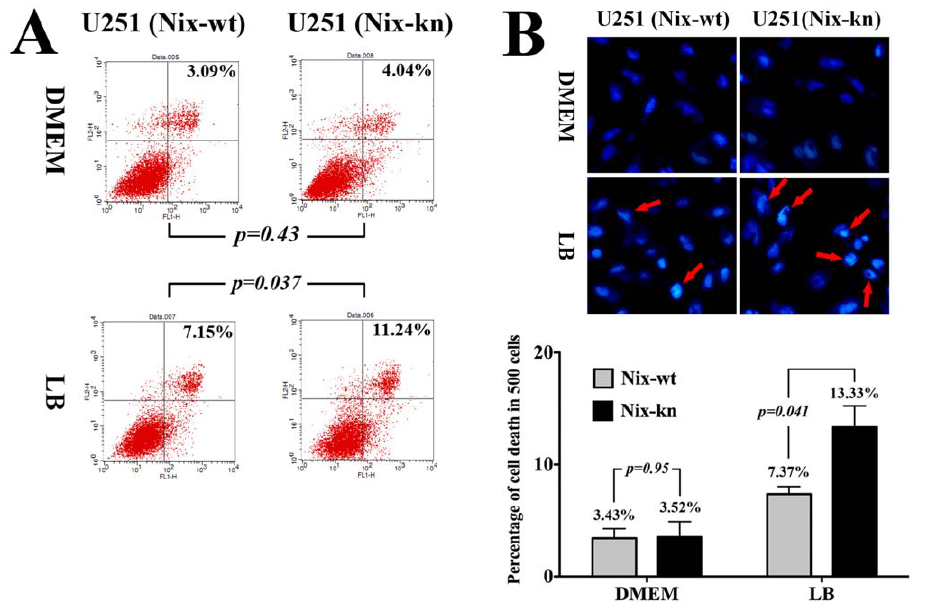
Figure 2. Nix protein improves cell survival in U251 cells cultured in nutritionally deficient conditions. (A) The apoptosis of Nix-wt and Nix-kn U251 cells with LB treatment and flow cytometry detection (Three repeated experiments). After LB medium was replaced with fresh DMEM + 10% FBS medium, the apoptosis ratios for Nix-kn and Nix-wt U251 cells were 11.24 6 2.15% and 7.15 6 0.87% ( p =0.037), with corresponding controls of 4.04 6 0.89% and 3.09 6 1.65% ( p =0.43), respectively. (B) The viability of Nix-wt and Nix-kn U251 cells with LB treatment by DAPI. The dead cells are indicated by red arrows. Performed in triplicate, 500 cells were randomly selected for analysis, and the rate of dead cells for LB Nix-kn and LB Nix-wt U251 cells were 13.33 6 3.28% and 7.37 6 1.17%, with corresponding controls of 3.52 6 2.4% and 3.43 6 1.47%, respectively. The statistic data indicated significantly more death cells in the LB Nix-kn than Nix-wt cells ( p =0.041); while no difference was found between DMEM groups.